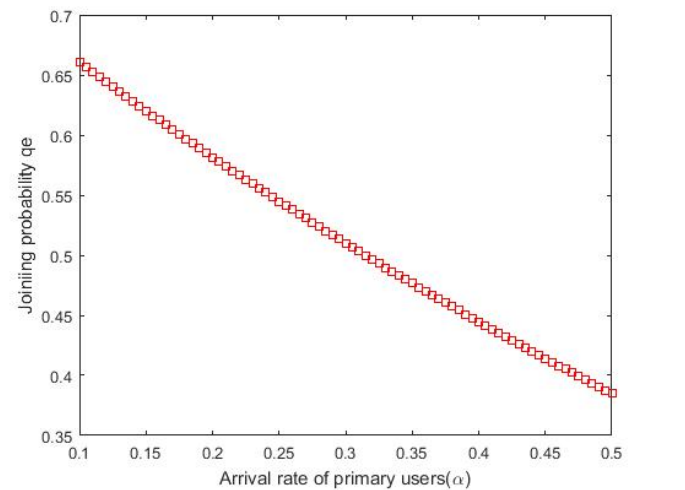
Figure 3. Equilibrium-joining probabilities vs. α when λ = 0.4, µ = 1, β = 0.5, θ = 0.7, η = 0.5, C = 1, R =